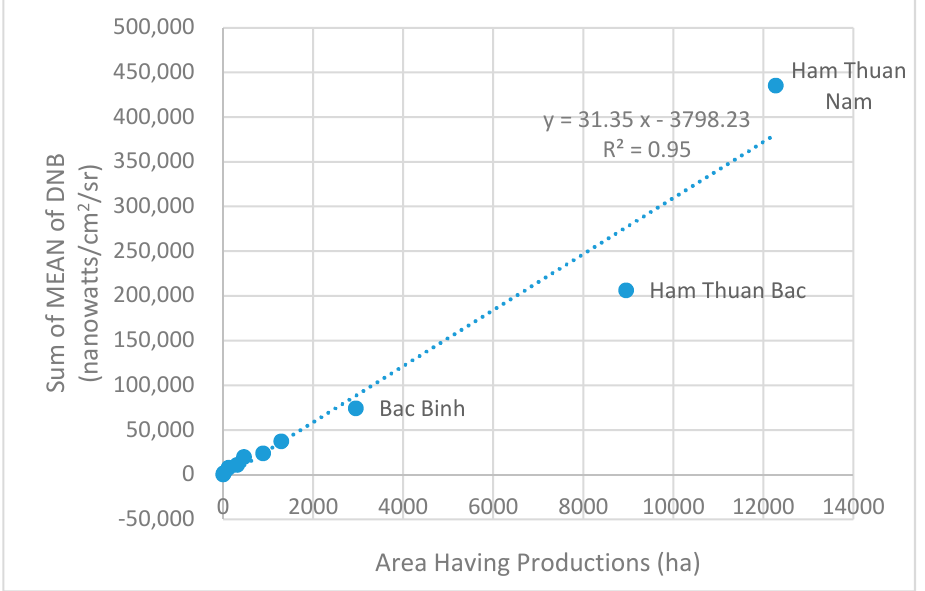
Figure 8. Pearson correlation between the sum of mean and the area having productions of dragon fruit.